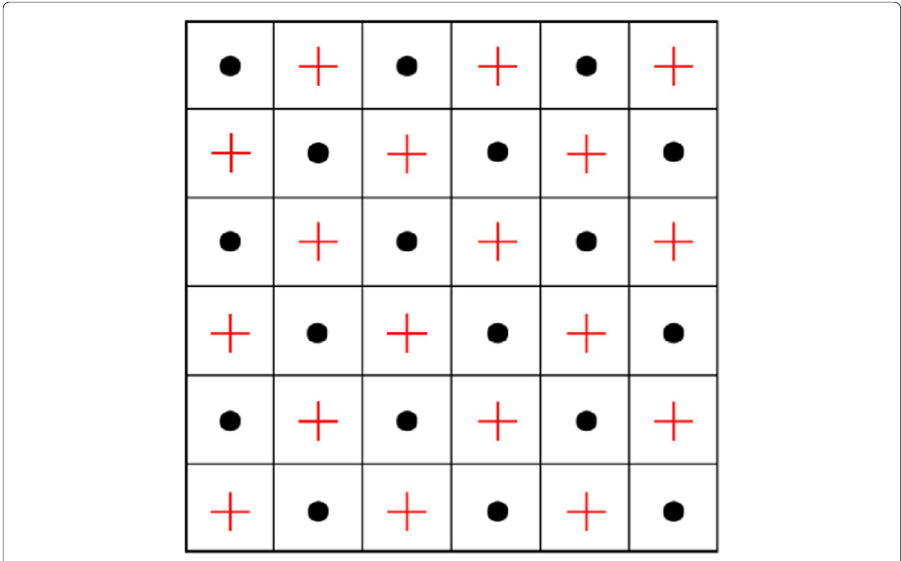
Fig. 2 Dot set and plus set in a non-pure block. The plus set stands for embeddable pixels, while dot set represents the shared prediction